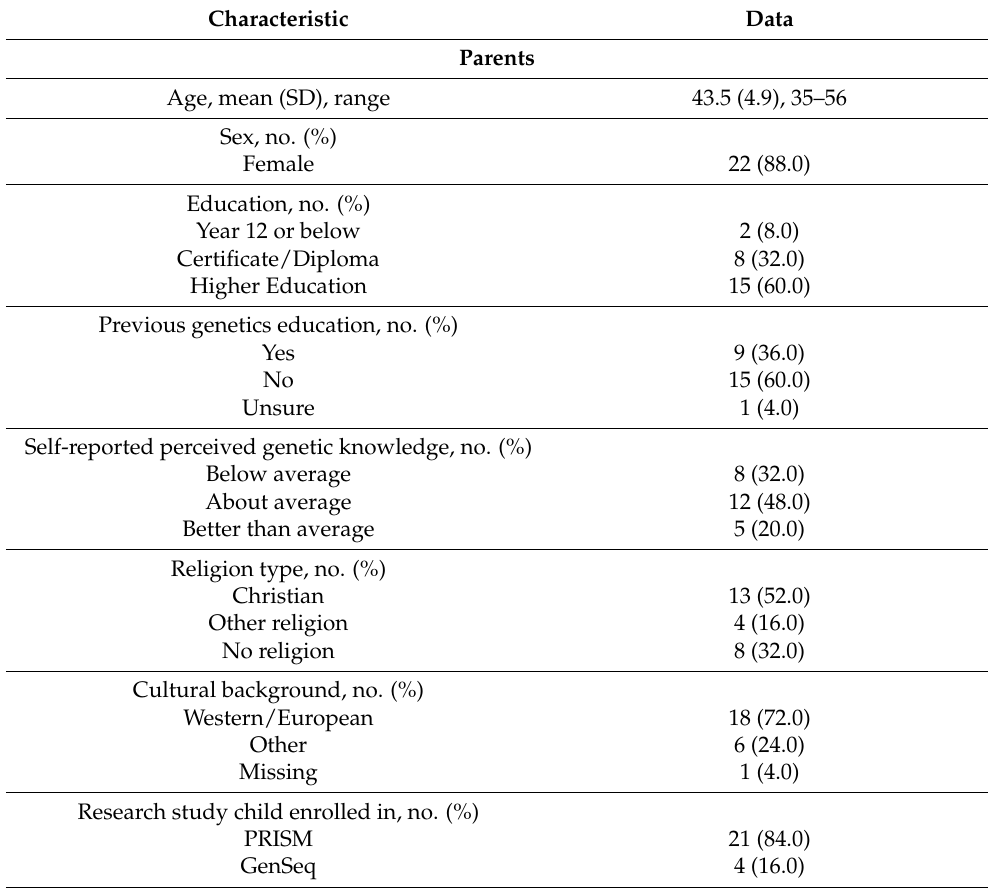
Table 1. Demographics, parents (n = 25) and patients of participating parents (n =